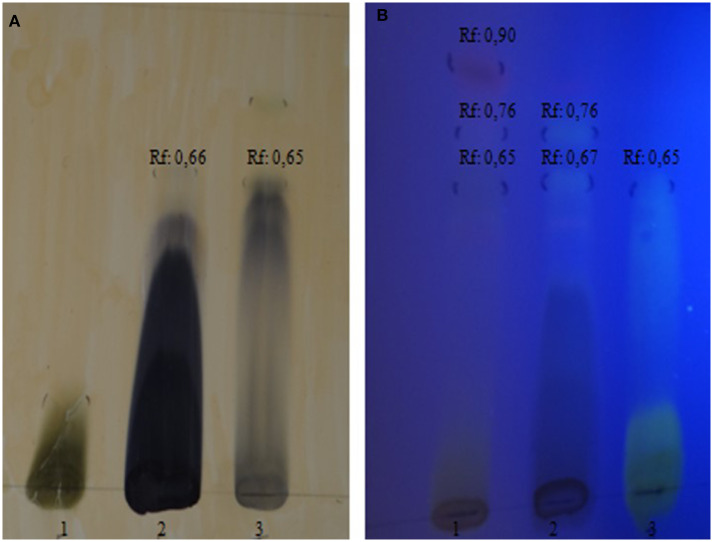
Chromatographic profile of the ethanolic extract from Libidibia ferrea obtained by thin layer chromatography. (A) hydrolysable tannins in visible light; 1: rutin standard; 2: tested extract; 3: green tea standard; (B) flavonoids in ultraviolet light; 1: green tea standard; 2: tested extract; 3: rutin standard.